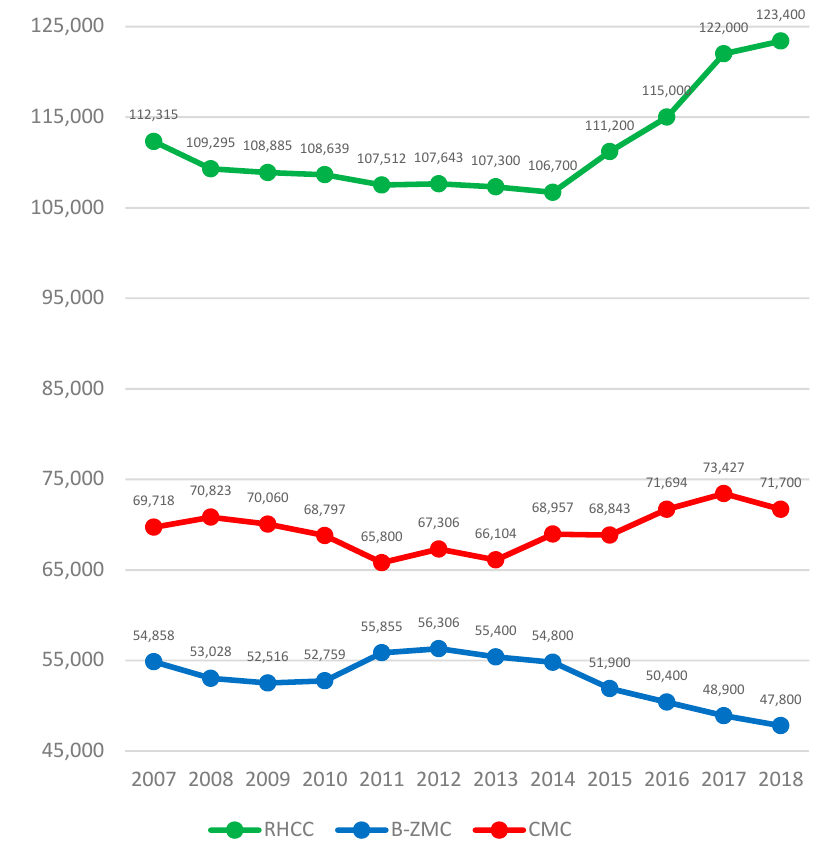
Figure 1. Trendline of visits to EDs at three hospitals in metropolitan Haifa, 2007–2018 (Rambam Health Care Campus (RHCC), Bnai-Zion Medical Center (B-ZMC), and Carmel Medical Center